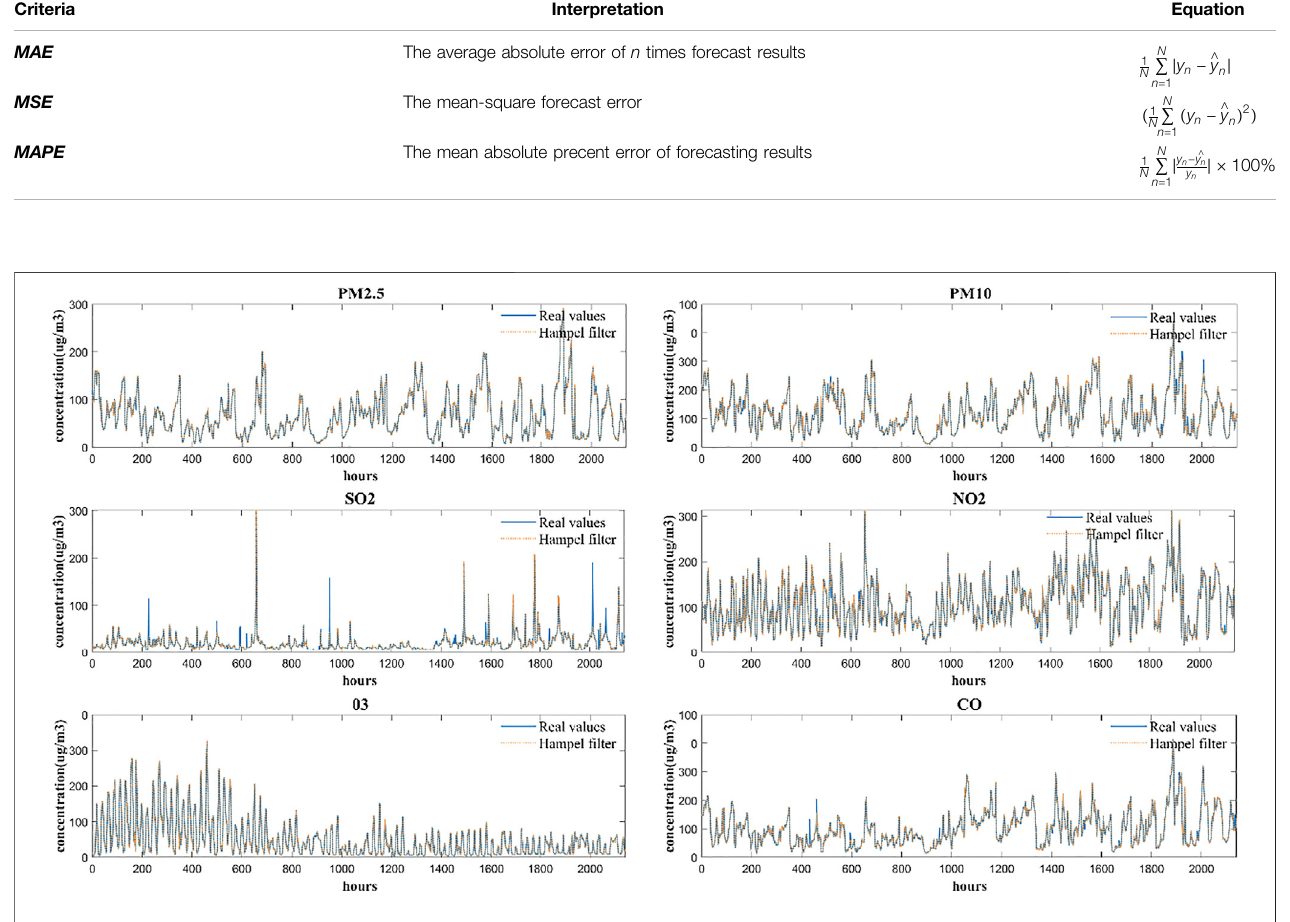
TABLE 1 | Evaluation criteria. Criteria